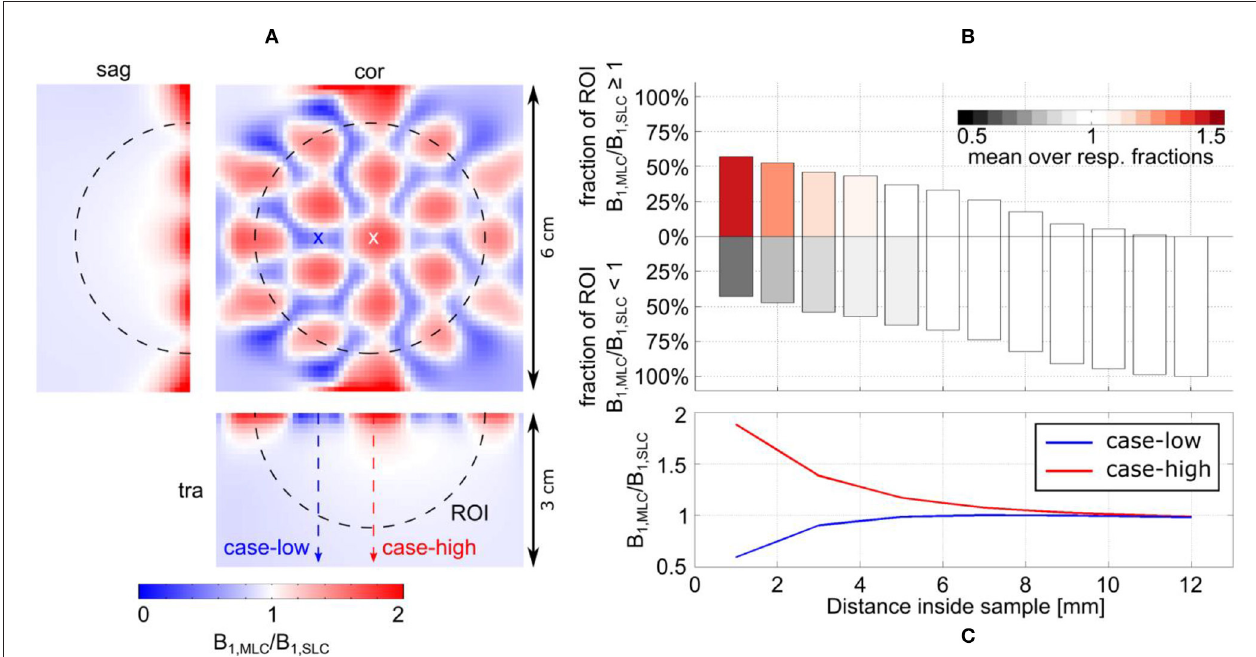
FIGURE 7 | Detailed analysis of the transmit efficiency ratio between MLC and SLC at 7T. (A) Ratio maps in the central sagittal and transversal slice as well as a coronal slice in a depth of 2mm. (B) Analysis of the ratio in the ROI shown by the dashed black line in (A) . The position of the bars along the y-axis shows the fractions of the ROI for which either the MLC or the SLC have higher transmit efficiency. The color of the bars indicates how much the ratio in the respective fractions deviates from 1; i.e., white indicates comparable performance (1 5%). (C) Line profiles parallel to the coil axis for locations of high (red dashed line and white cross, ± “case-high”) and low (blue dashed line and cross, “case-low”) B 1 intensity of the MLC.